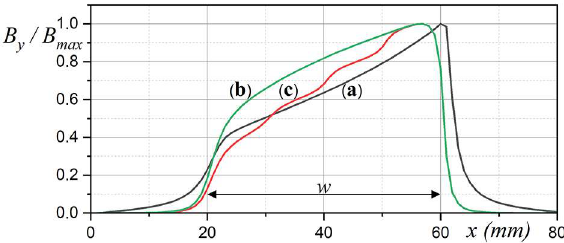
Figure 14. Relative magnetic flux density in the air gap over the non-symmetric magnetic pole of SM. Comparison: electrically excited SM with optimized air gap ( a ); PM excited SM with constant magnetization in the y -direction ( b ); PM divided into 4 parts with optimized magnetization in the y -direction ( c ).